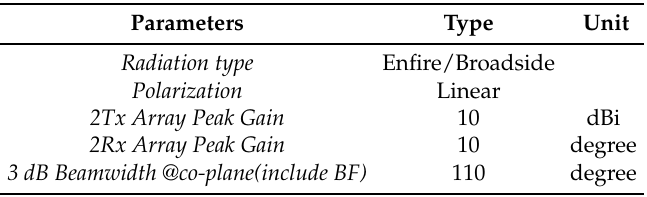
Table 1. mmWave antenna specifications.